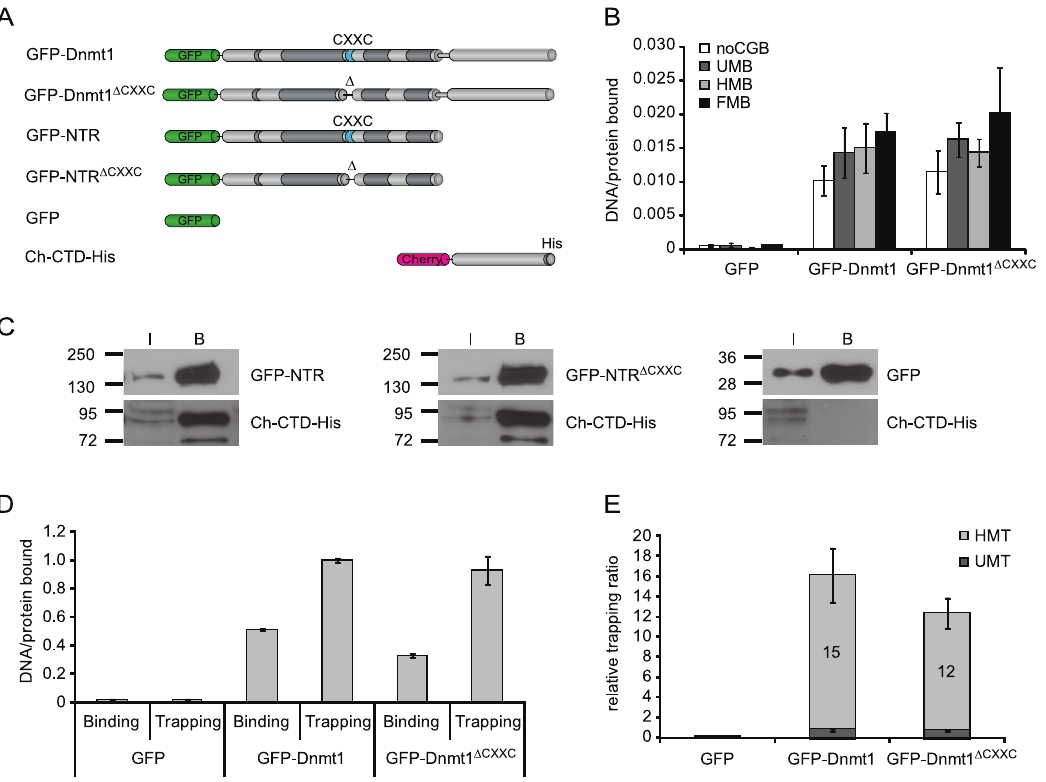
Figure 4. DNA binding specificity, intramolecular interaction and trapping of wild-type Dnmt1 and CXXC deletion constructs in vitro . ( A ) Schematic representation of Dnmt1 expression constructs. ( B ) DNA binding specificity of GFP-Dnmt1 and GFP-Dnmt1 D CXXC were assayed as described in Figure 2C. ( C ) Co-immunoprecipitation of the C-terminal domain of Dnmt1 (Ch-CTD-His) and the N-terminal region with and without deletion of the CXXC domain (GFP-NTR and GFP-NTR D CXXC , respectively). GFP fusions were detected using an anti-GFP antibody, while the C-terminal domain construct was detected using an anti-His antibody. GFP was used as negative control. I = input, B = bound. ( D ) Comparison of binding and trapping activities for GFP-Dnmt1 and GFP-Dnmt1 D CXXC to monitor irreversible covalent complex formation with hemimethylated substrates. ( E ) Relative covalent complex formation rate of GFP-Dnmt1 and GFP-Dnmt1 D CXXC on substrates containing one un- (UMT) or hemi-methylated CpG site (HMT) in direct competition. The trapping ratio for GFP-Dnmt1 on unmethylated substrate was set to 1. In (D) and (E) the means and corresponding standard deviations of triplicate samples from three independent experiments are shown. GFP was used as negative control.